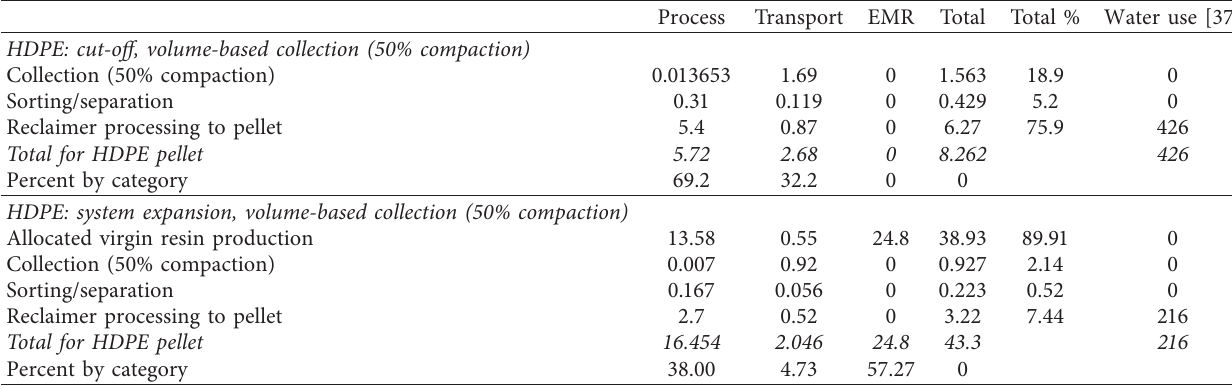
Table 10: Energy and water use for recycled HDPE resin (MBtu of energy and liter of water per ton of